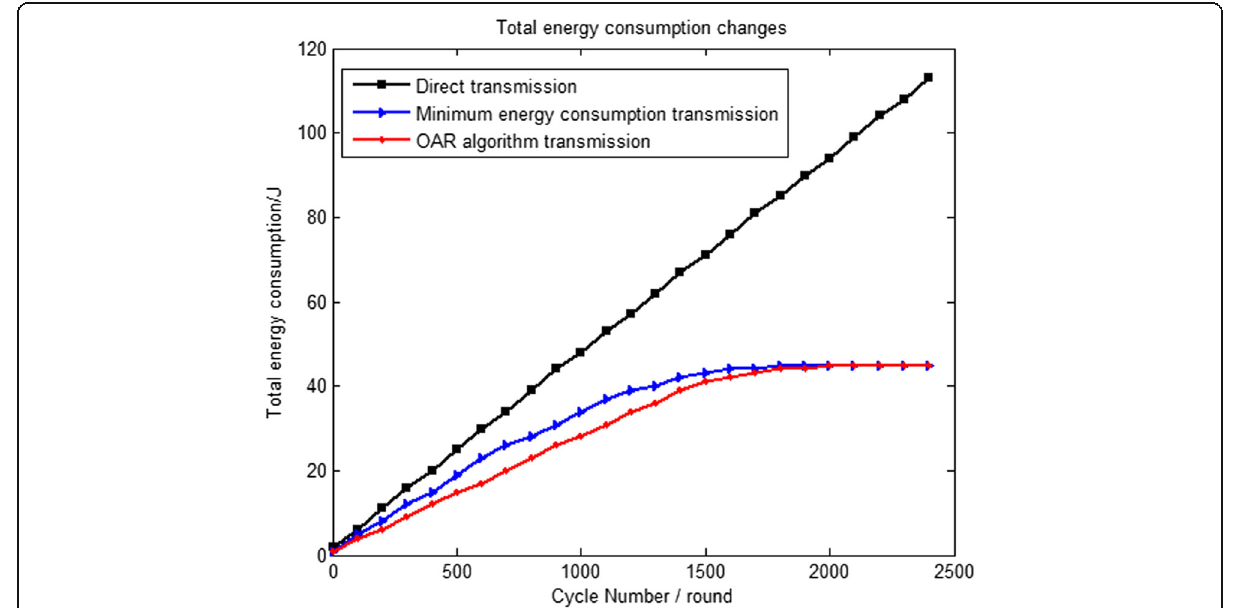
Fig. 5 The total energy consumption of the network